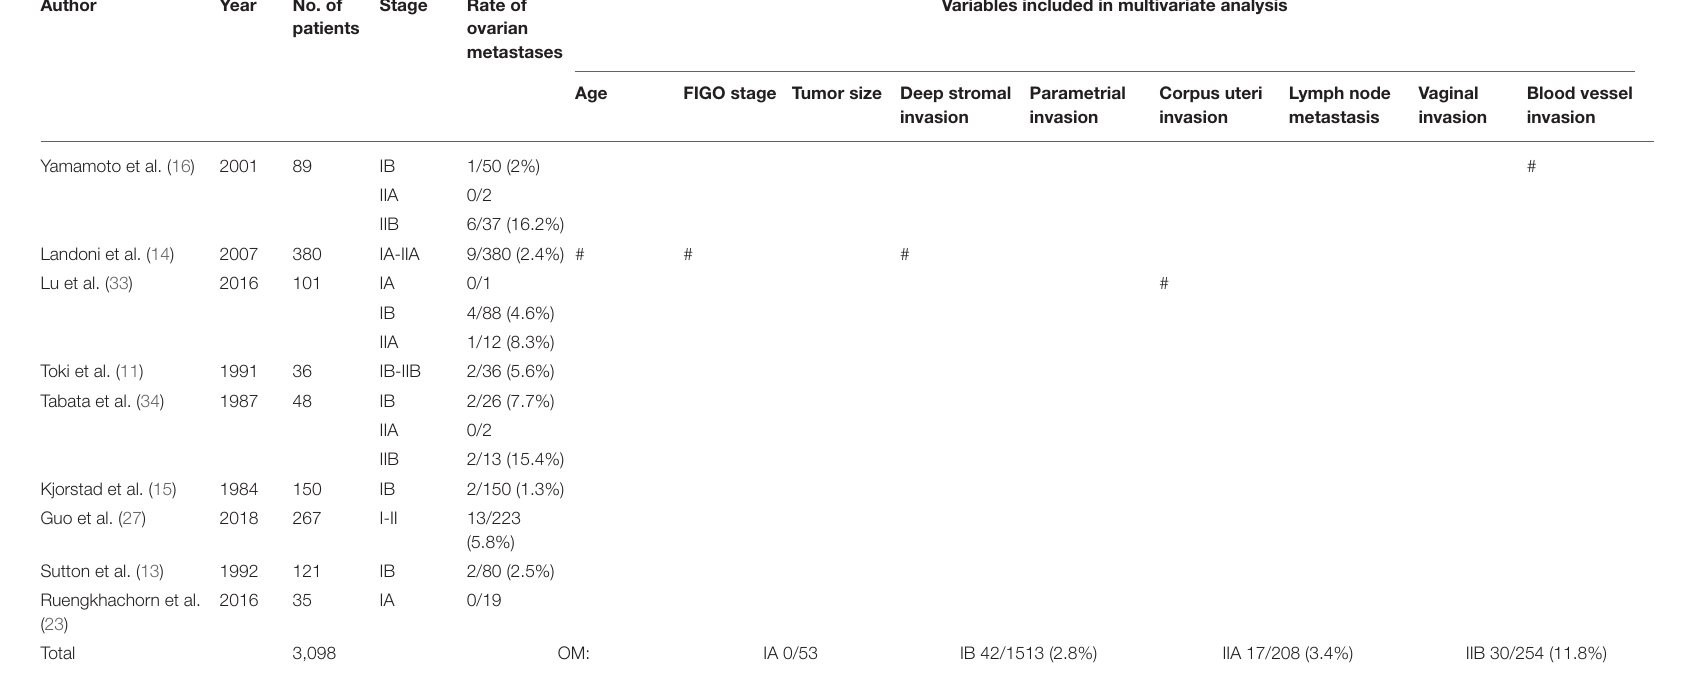
No., number; FIGO, International Federation of Gynecology and Obstetrics. * Prognostic factors for cervical adenocarcinoma. # Risk factors for ovarian